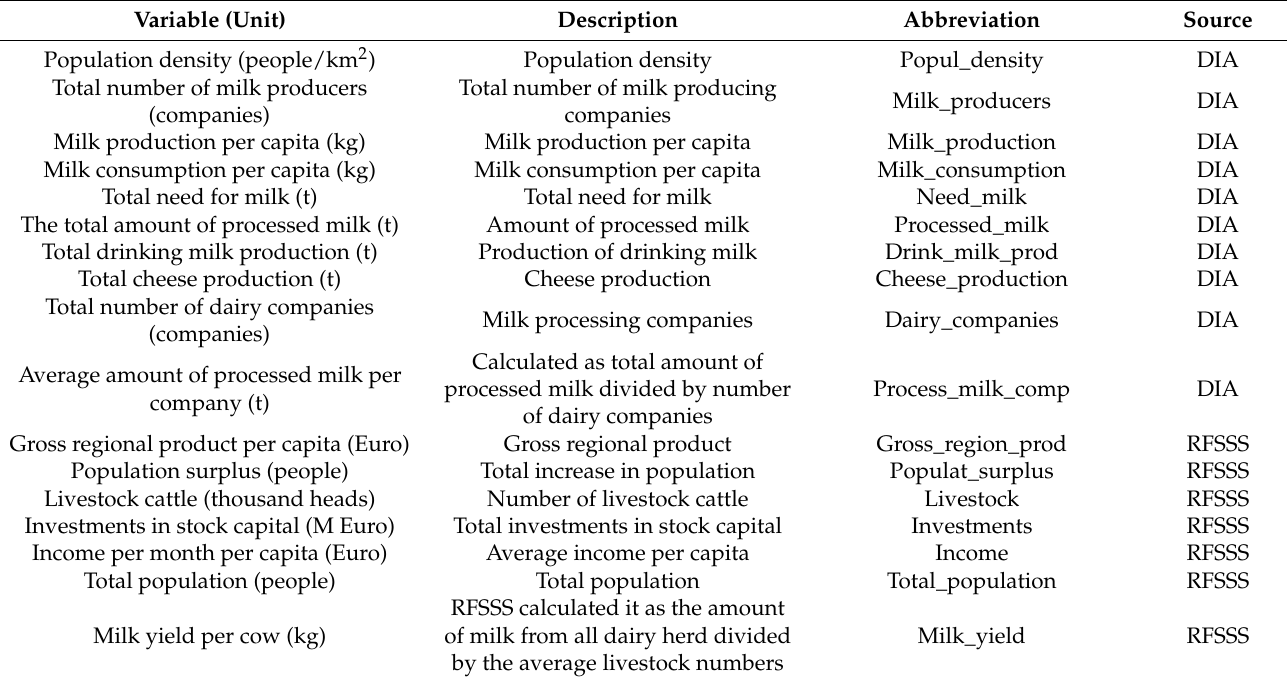
Table 1. All 17 collected explanatory variables (variable in each